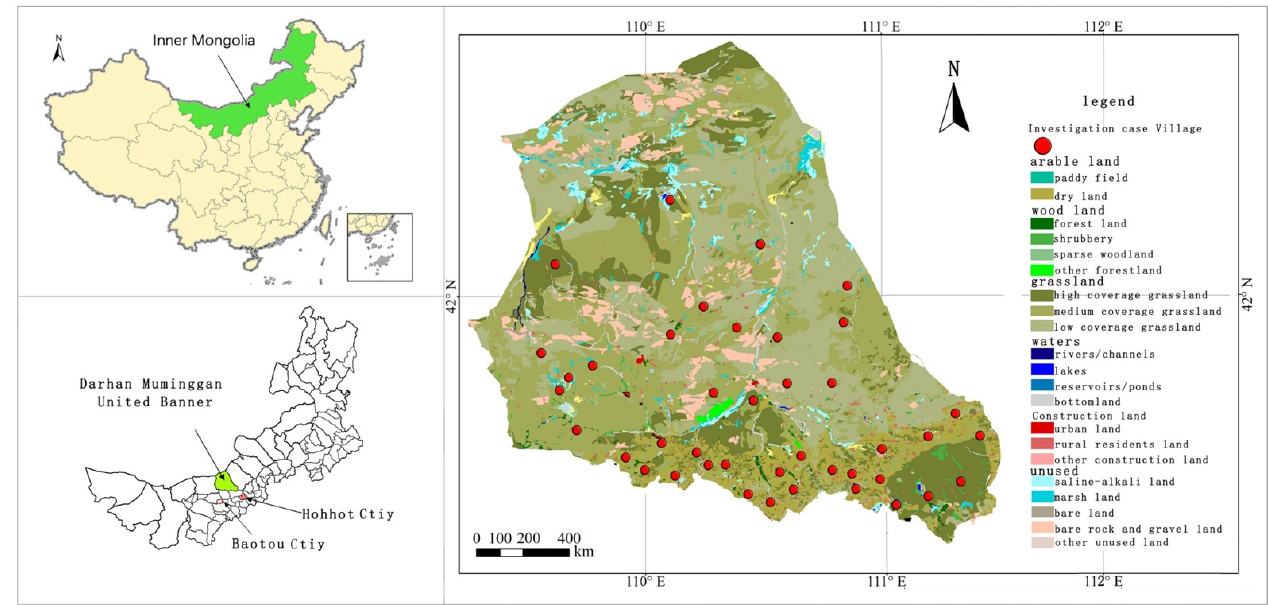
Figure 4. Study area and sampling points.